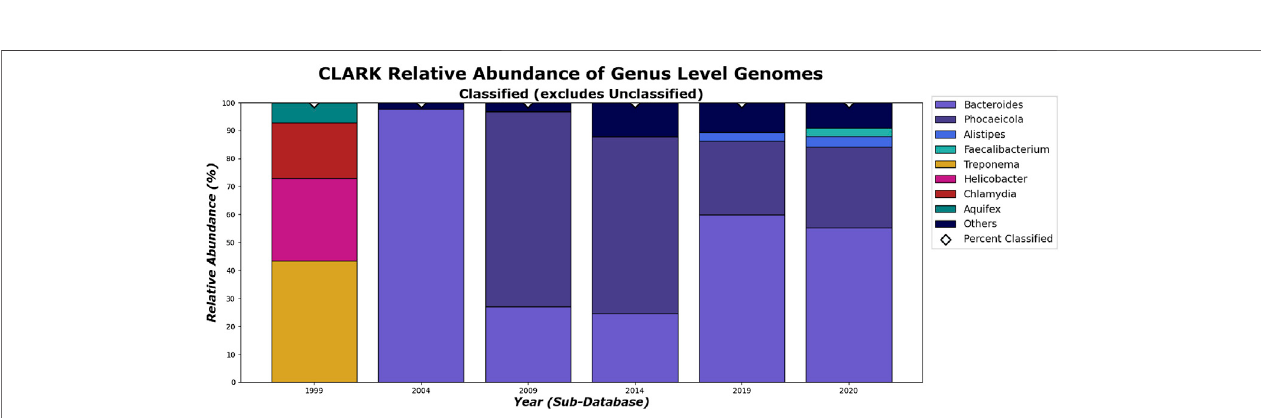
FIGURE 12 | CLARK ’ s classi fi ed relative abundance for Genus Level. Only taxa whose classi fi ed relative abundance was at least 3% are shown as a colored bar here. Only bars for classi fi ed reads are included. The percentage of classi fi ed reads traced back to genus level for each year are shown as diamond markers.